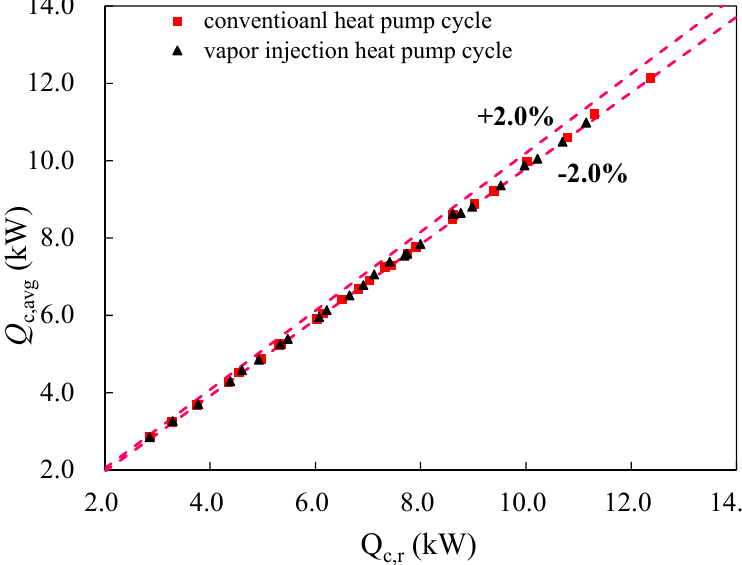
Figure 4. The energy balances of heating capacities.